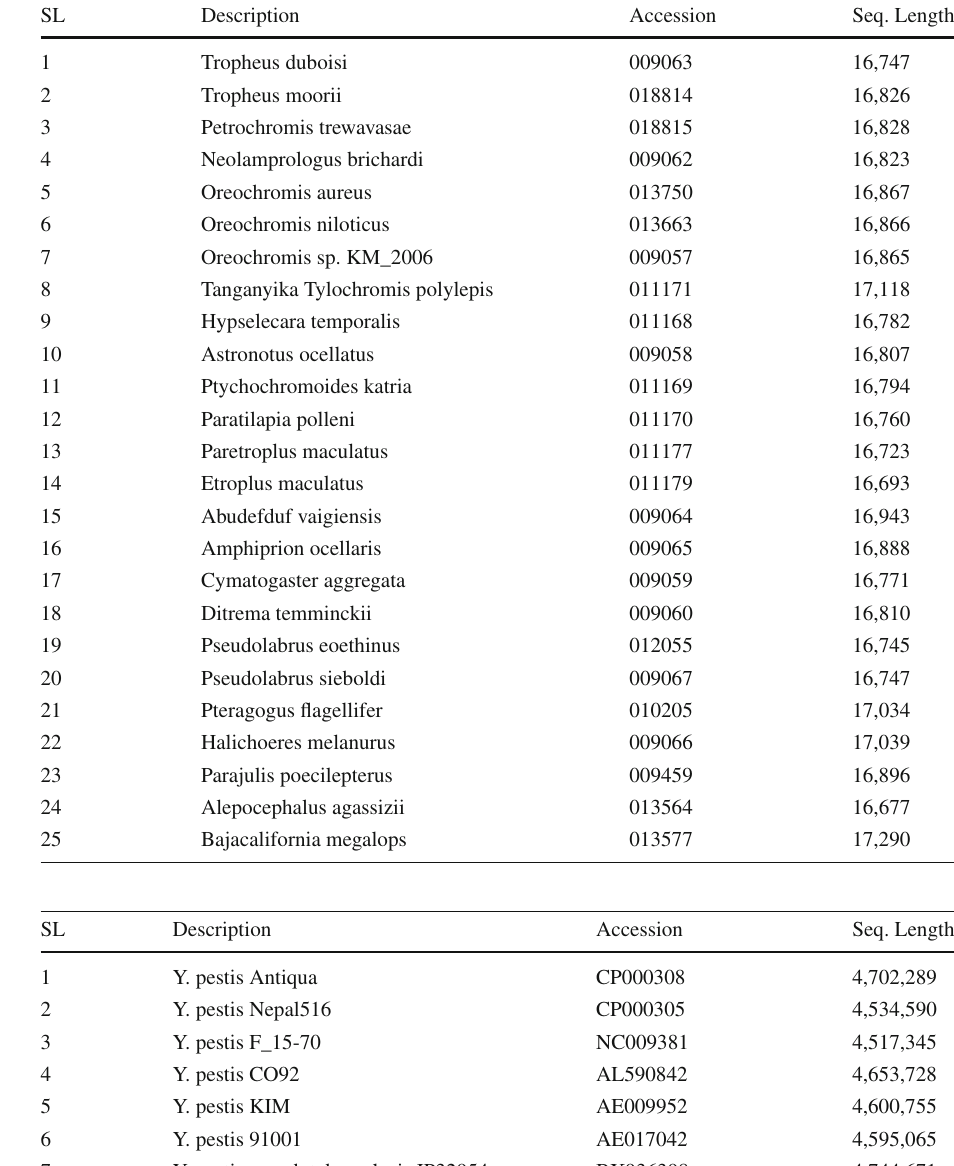
Table 1 Description of 25 cichlid fish genome sequences